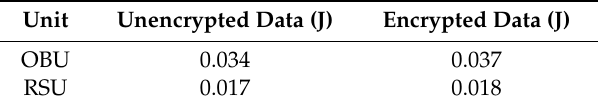
Table 7. Energy consumption for data